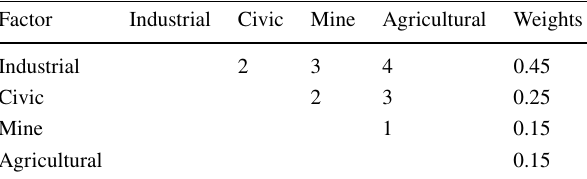
Table 3 Weights of the pollutant resources factor assigned by